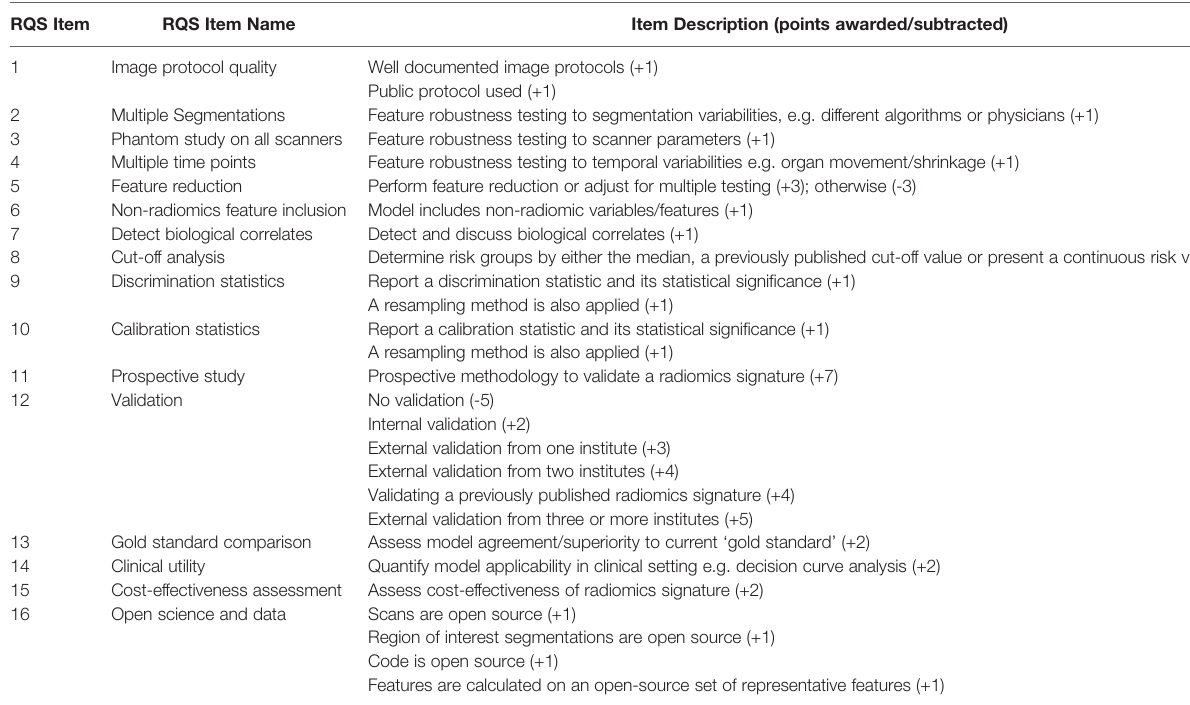
TABLE 2 | Details of RQS items and associated points awarded/deducted at each